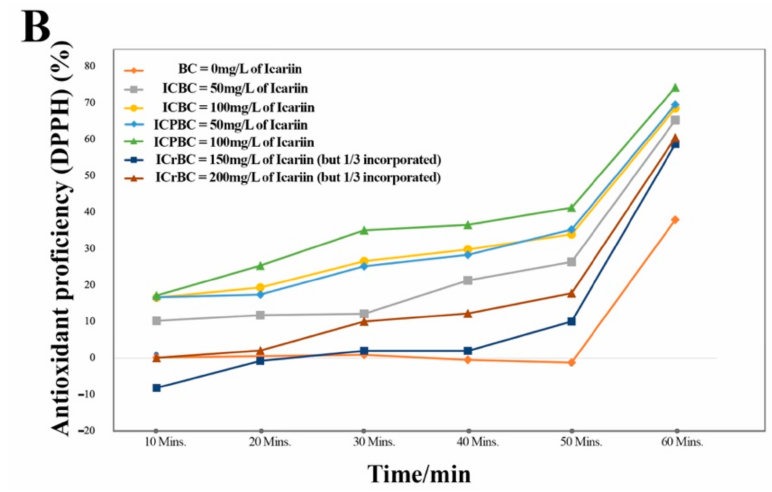
Figure 8. ( A ) DPPH Radical Scavenging activity (Blank, BC and drug loaded samples) and ( B ) antioxidant proficiency per icariin dosage as a function of time; involving BC, ICBC 50 & 100 mg, ICPBC 50 & 100 mg and ICrBC samples.